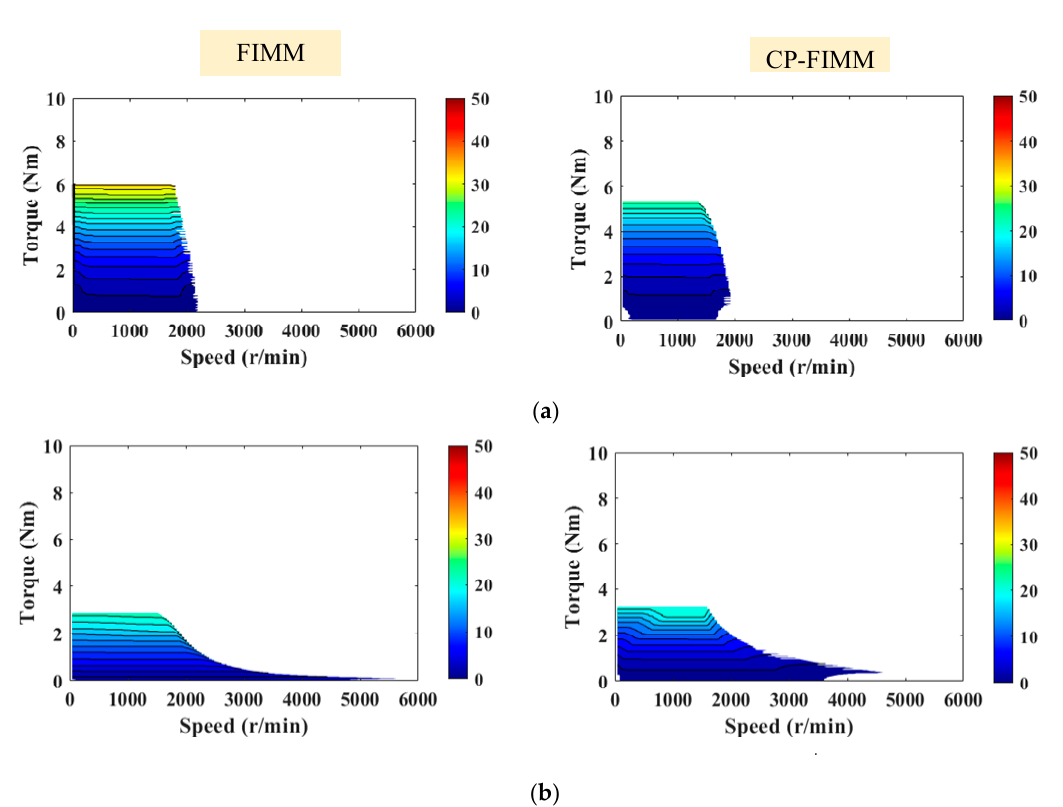
Figure 17. Copper loss maps of FIMM and CP-FIMM. ( a ) Flux-enhanced; ( b ) flux-weakened.